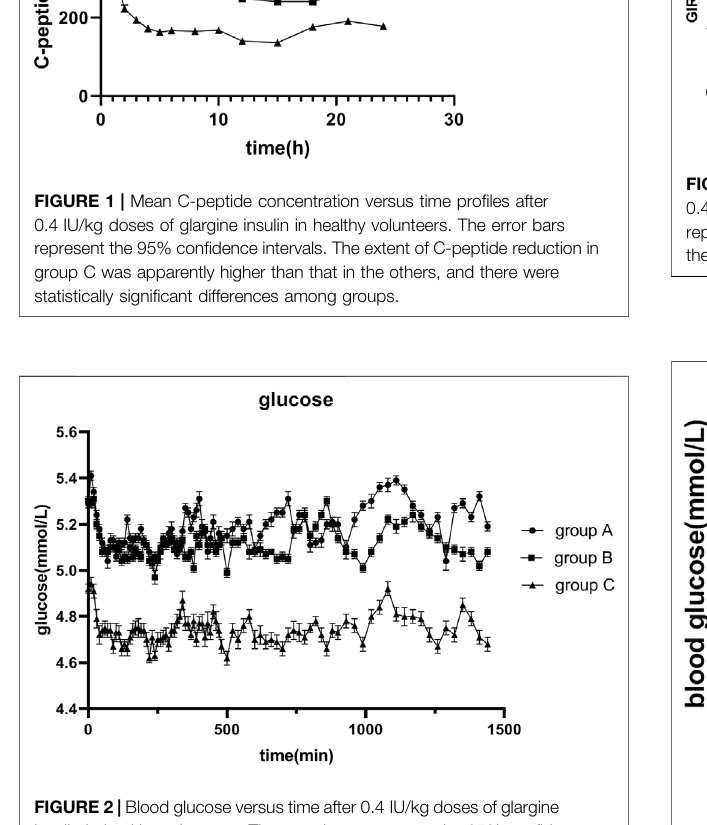
FIGURE 4 | Relationship between the ratio of C-peptide reduction and blood glucose, in which revealed a negative